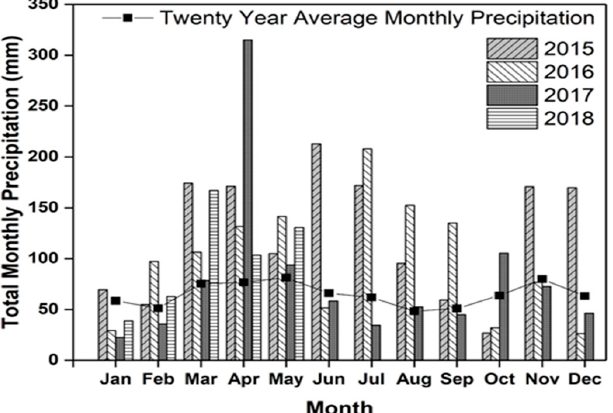
Figure 2. Total monthly precipitation at the research site from 2015 to 2018 with a twenty-year average of monthly precipitation from 1993 to 2014.